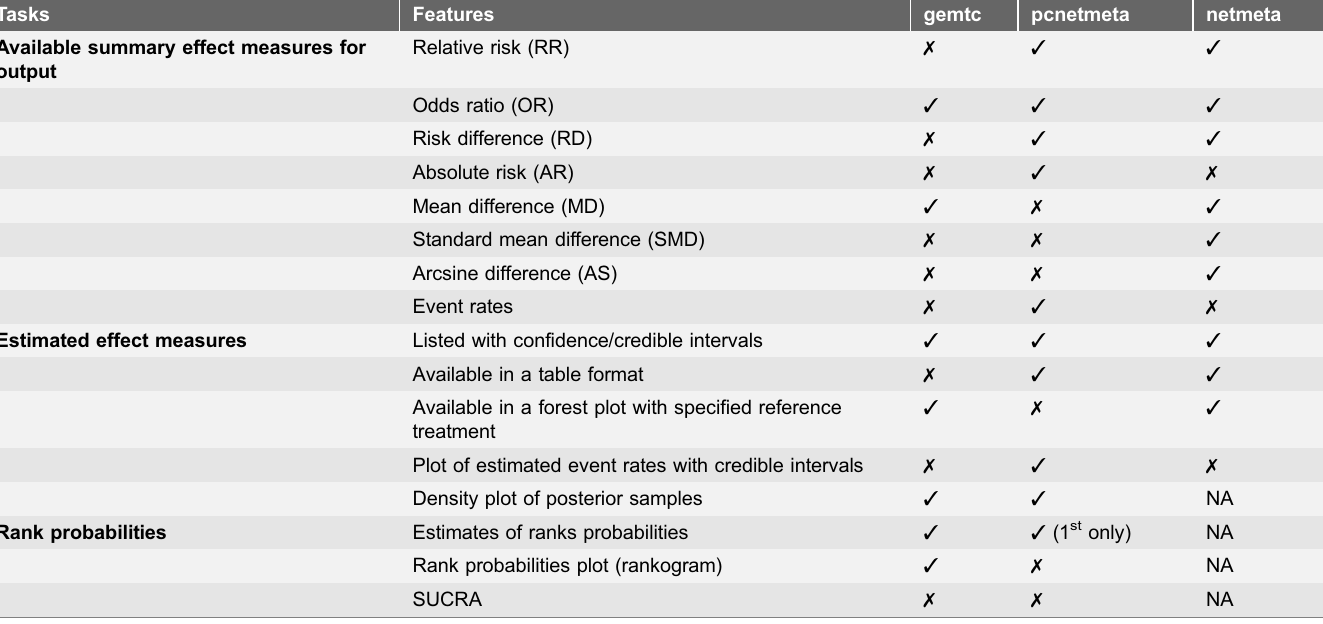
Table 4. Inference and reporting tools available from NMA R packages gemtc, pcnetmeta and netmeta. Tasks Available summary effect measures for output